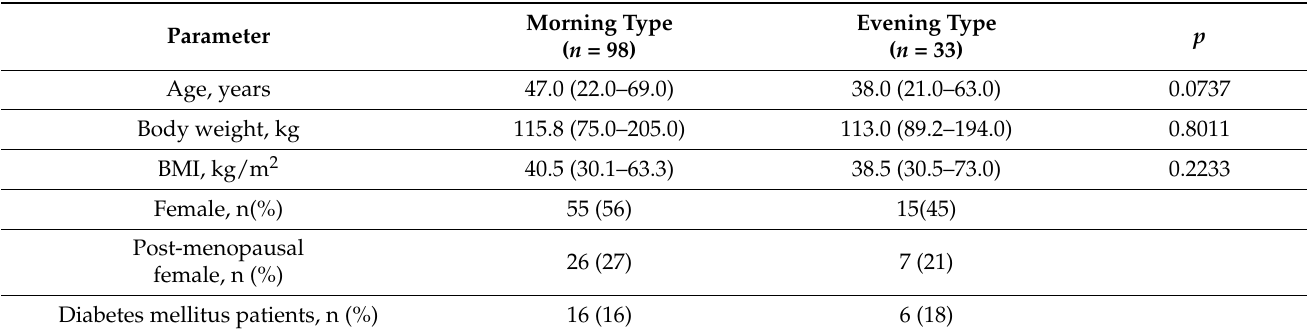
Table 1. Anthropometric characteristics of all study participants by chronotype ( n = 131); Kruskal–Wallis test. The values of the results in the study are given as a median (minimum–maximum). BMI (Body Mass Index). Morning Type Evening Type p Parameter ( n = 98) ( n = 33) Age, years 47.0 (22.0–69.0) 38.0 (21.0–63.0) 0.0737 Body weight, kg 115.8 (75.0–205.0) 113.0 (89.2–194.0) 0.8011 BMI, kg/m 2 40.5 (30.1–63.3) 38.5 (30.5–73.0) 0.2233 Female, n(%) 55 (56) 15(45) Post-menopausal female, n (%) Diabetes mellitus patients, n